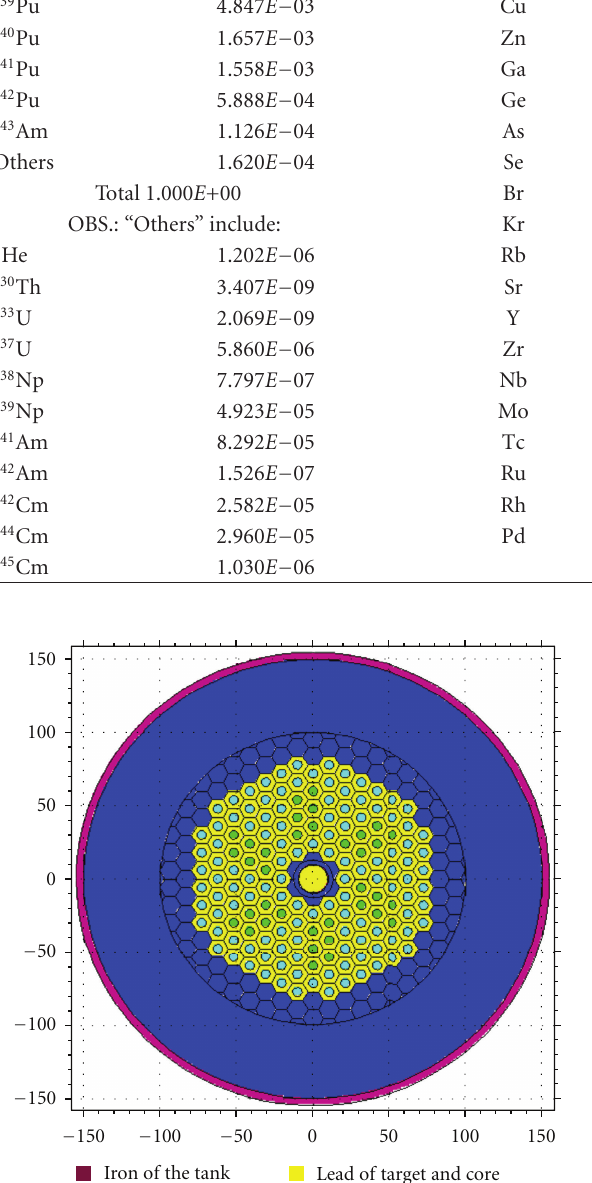
Figure 2: Vertical cross section of the ADS simulated. cross sections of fission products will reduce the k e ff variation and produce a hardening (shift to higher energies) in the neutron energy distribution. So, the inventory of 233 U